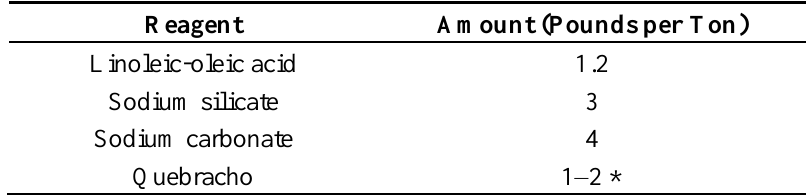
Table 1. Depressant Dosing Amounts